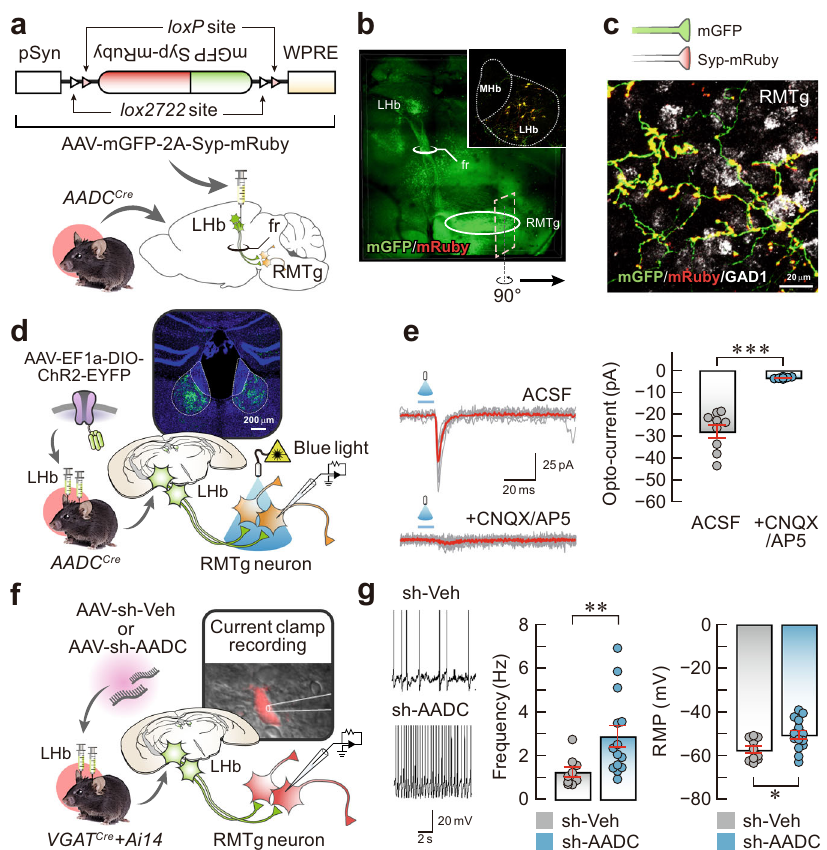
Fig. 4 | LHb D-neurons innervate RMTg GABAergic neurons. a Schematic of the AAV used and experimental procedure for anterograde tracing. b Representative AAV-hSyn-mGFP-Syp-mRuby infection pattern in the LHb (inset) and the sagittal fl uorescent image showing LHb D-neuron projections. c , A rotated and magni fi ed imageoftheregionofinterest(dashedsquare)from( b ).LHbD-neuronalterminals on GABAergic neurons of the RMTg were detected by FISH. d Schematic of AAV- ChR2injectionintotheLHbandtheresponseofRMTgGABAergicneuronstobrief optical stimulation. e Traces from oEPSCs (left) and summary data on normalised oEPSC amplitude under baseline conditions after CNQX (20 μ M) and AP5 (50 μ M) suggesting that most RMTg GABAergic neurons could be affected by trace amines. (Fig. 5e). RO5263397 (500 nM) application suppressed the